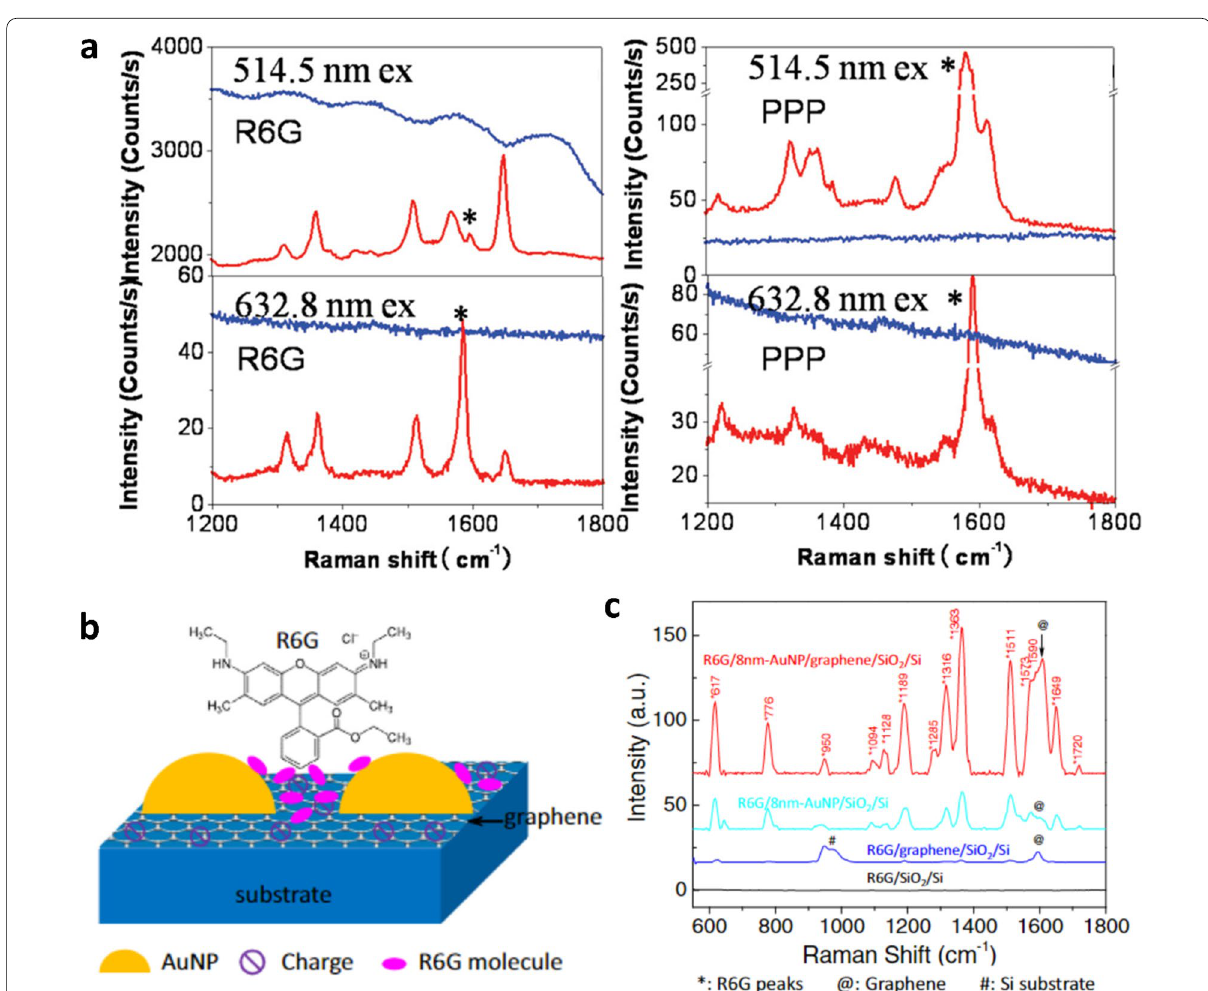
Fig. 4 Roles of graphene in graphene-based plasmonic materials. a Graphene as a FL quencher: comparisons of Raman signals of R6G and PPP deposited on graphene (red line) and on the SiO 2 /Si substrate (blue line) at 514.5 nm excitation and 632.8 nm excitation. The asterisk (*) indicates G-band peak of graphene. Reprinted with permission from [54]. Copyright 2010 American Chemical Society. b , c Graphene as a substrate material for hybrid structures: b Schematic diagram of R6G molecules attached on AuNPs/graphene/SiO 2 /Si substrate for SERS, c Raman spectra for R6G on AuNPs/graphene/SiO 2 /Si (red), AuNPs/SiO 2 /Si (cyan), graphene/SiO 2 /Si (blue), and bare SiO 2 /Si (black). Reprinted from High sensitivity surface enhanced Raman spectroscopy of R6G on in situ fabricated Au nanoparticle/graphene plasmonic substrates, Rongtao Lu et al., Copyright 2015, with permission from Elsevier